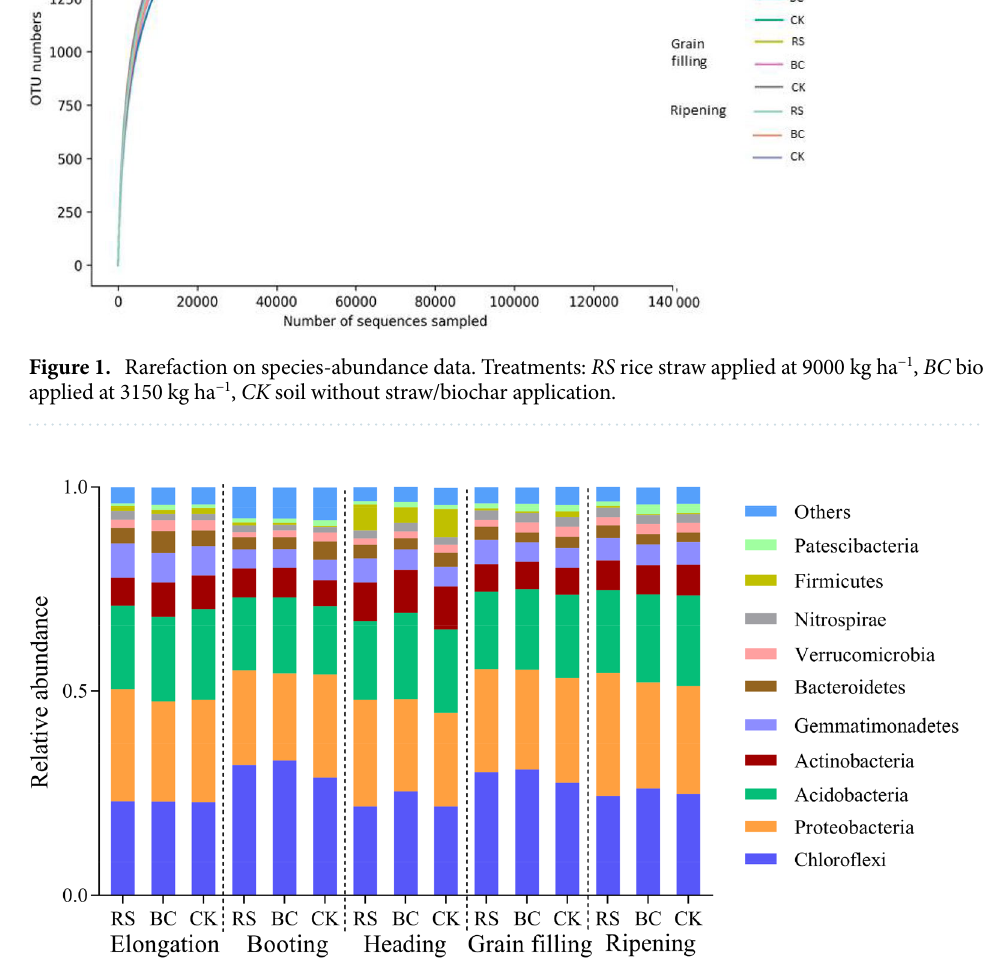
Figure 2. Phylum level bacterial community composition following the rhizosphere treatments. Treatments: RS rice straw applied at 9000 kg ha −1 , BC biochar applied at 3150 kg ha −1 , CK soil without straw/biochar